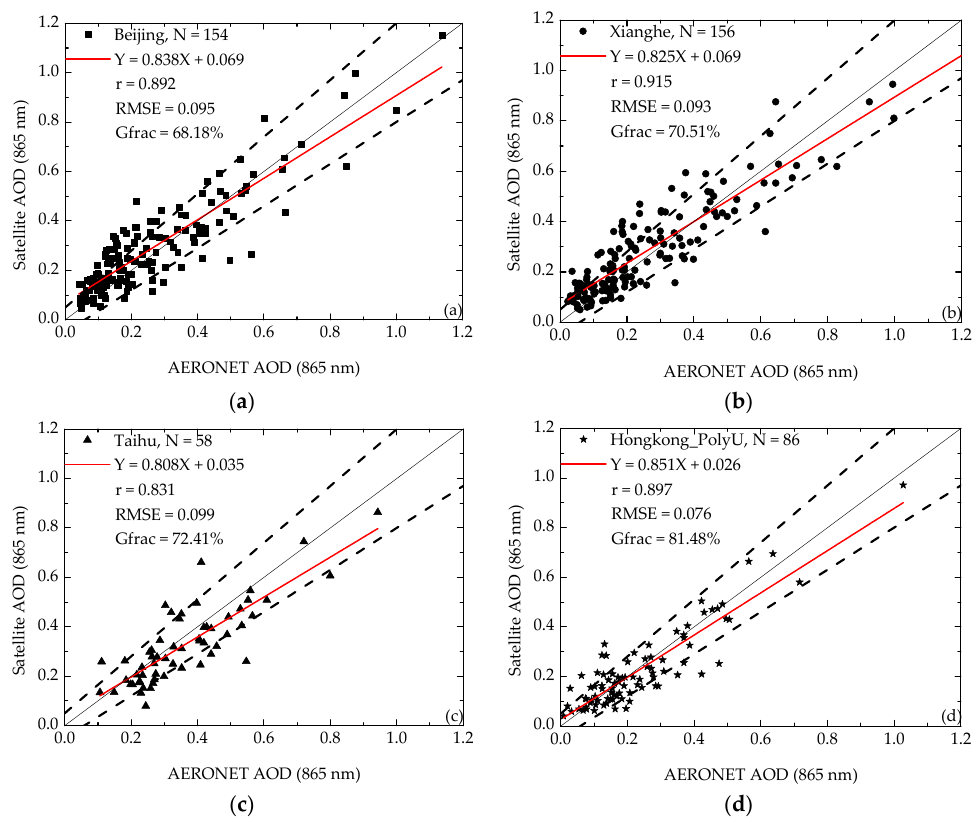
Figure 4. The validation results compared to the Aerosol Robotic Network (AERONET) ground-based observations. ( a ), ( b ), ( c ), and ( d ) are the validation results for the Beijing, Xianghe, Taihu, and Hongkong_PolyU sites, respectively. RMSE, root mean square error; Gfrac, good fraction. Table 1. Statistical results of the mean AERONET and retrieved AOD (865 nm). MAE, mean absolute